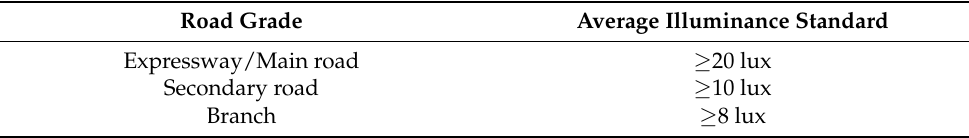
Table 3. Average illuminance standard for road grades [18,38].